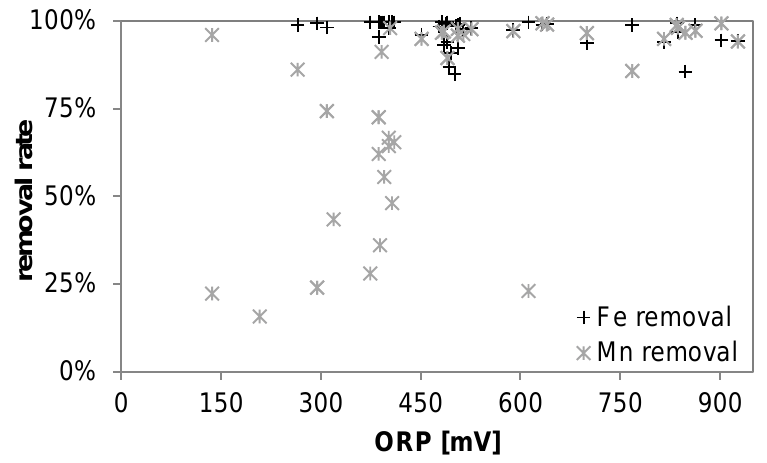
Figure 12. Removal rates of iron and manganese in relation ORP (values of P3 are omitted).